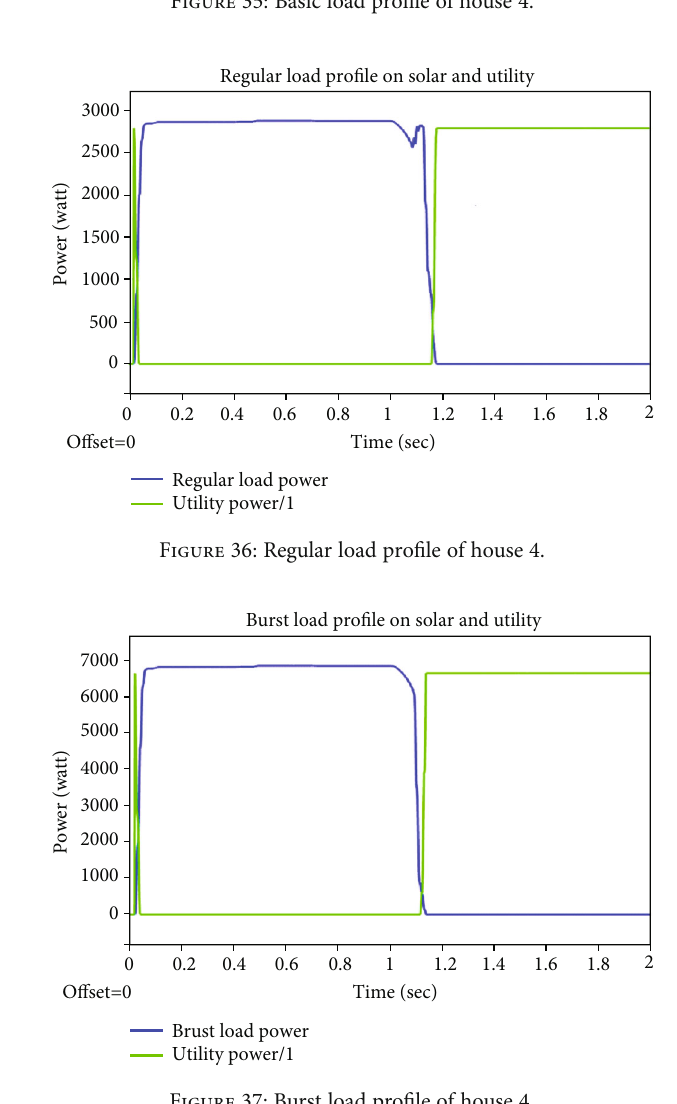
Figure 37: Burst load pro fi le of house